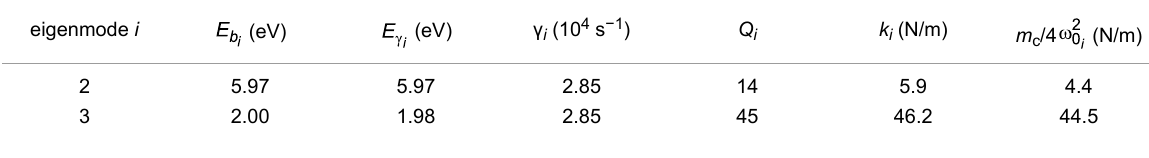
Table 3: Total dissipated energy calculated by a balance of potential and kinetic energy ( ) and by integrating the dissipative forces ( ). Quality factors are derived as Q i = 2 π f i / γ i , where the damping coefficient γ i = 2/ τ i , see Table 2). Finally, the elastic constant derived from the theoretical scaling ( k